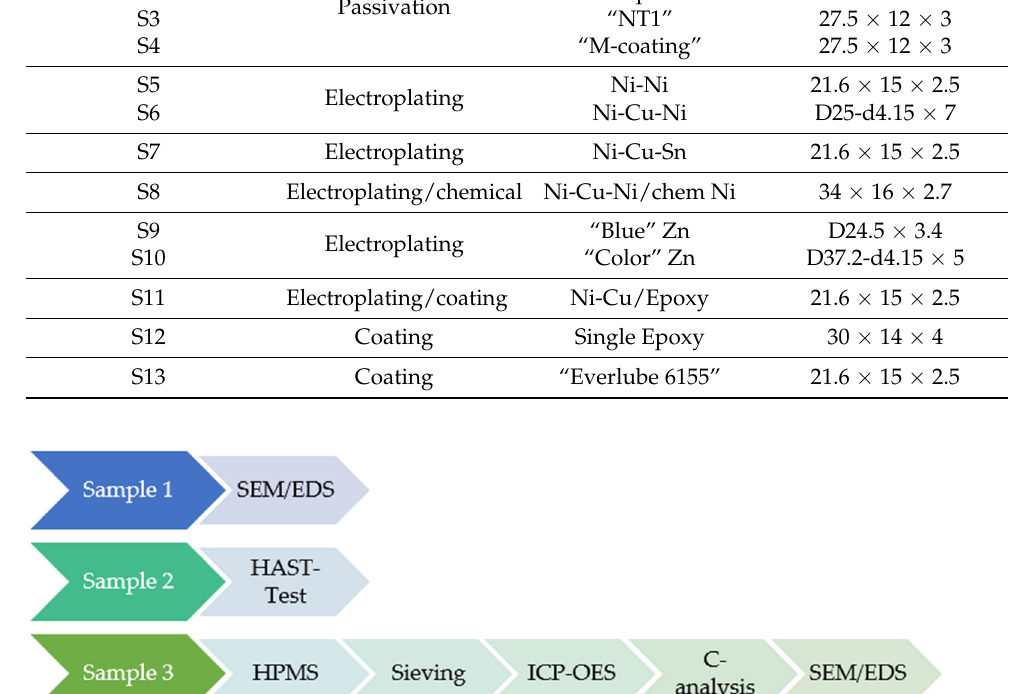
Figure A1. Overview of the sample splitting and the used analysis methods.